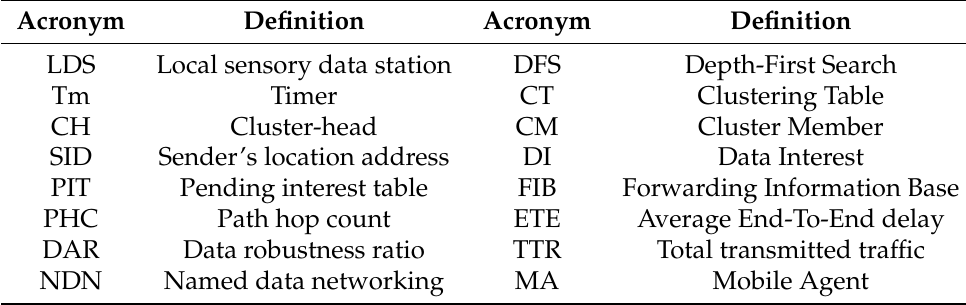
Table 1. A glossary for